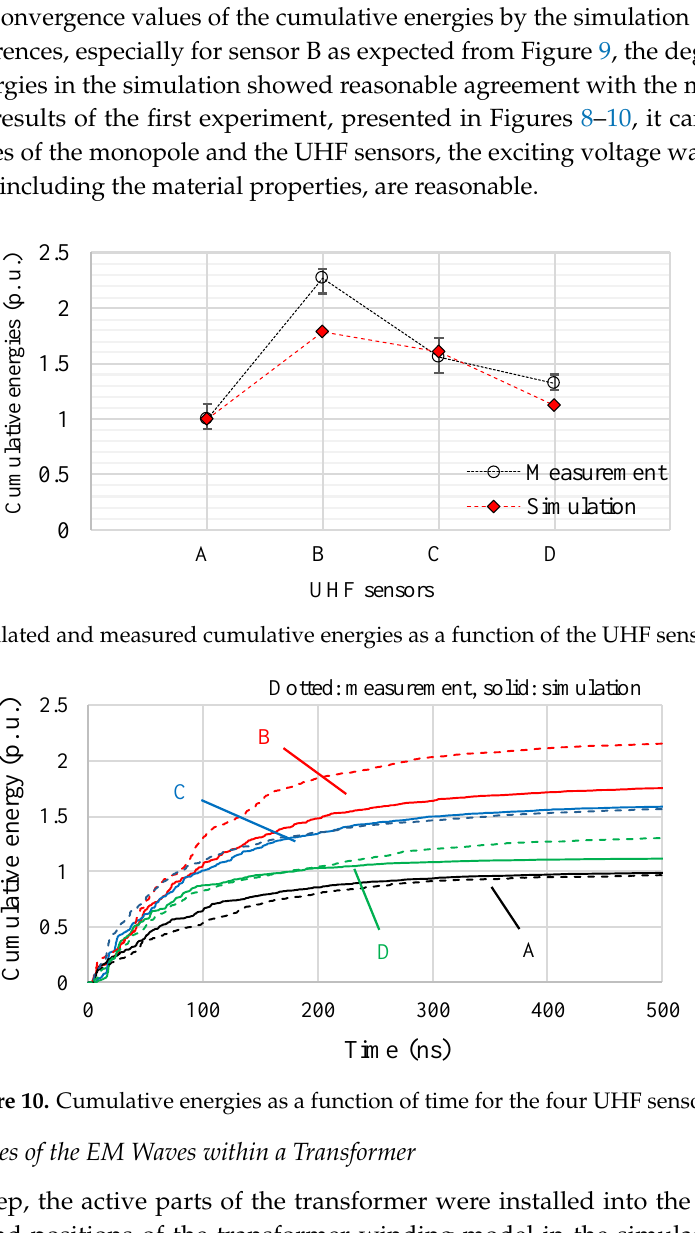
Figure 10. Cumulative energies as a function of time for the four UHF sensors.